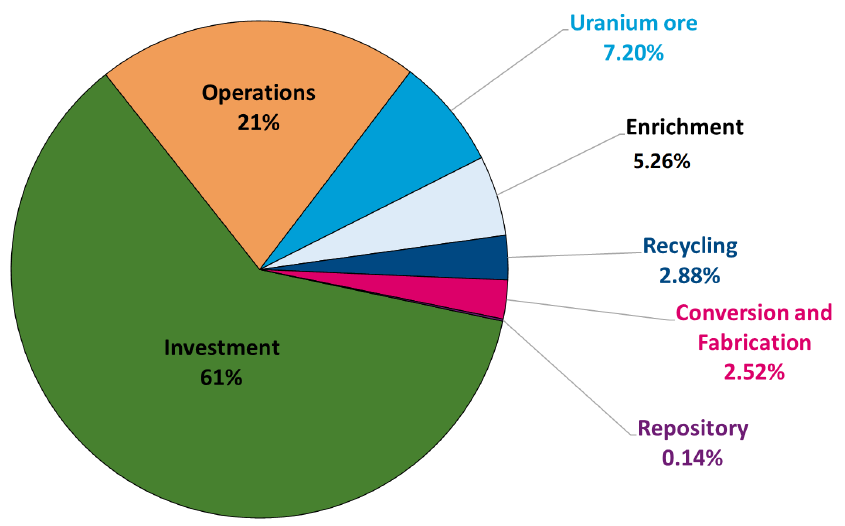
Figure 12. Relative contributions of nuclear fuel cycle stages to the total cost of nuclear electricity in France (TTC) [13].